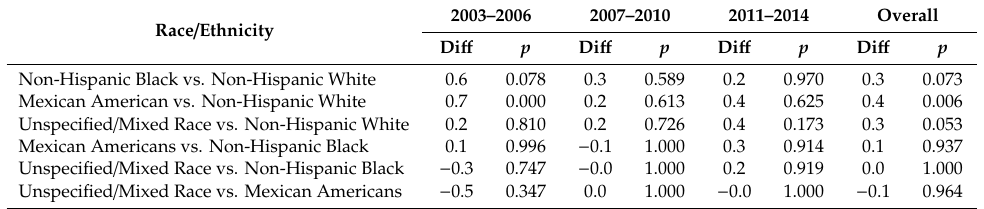
Table 2. Adjusted pairwise comparisons of marginal linear prediction of hemoglobin A1C by race / ethnicity.